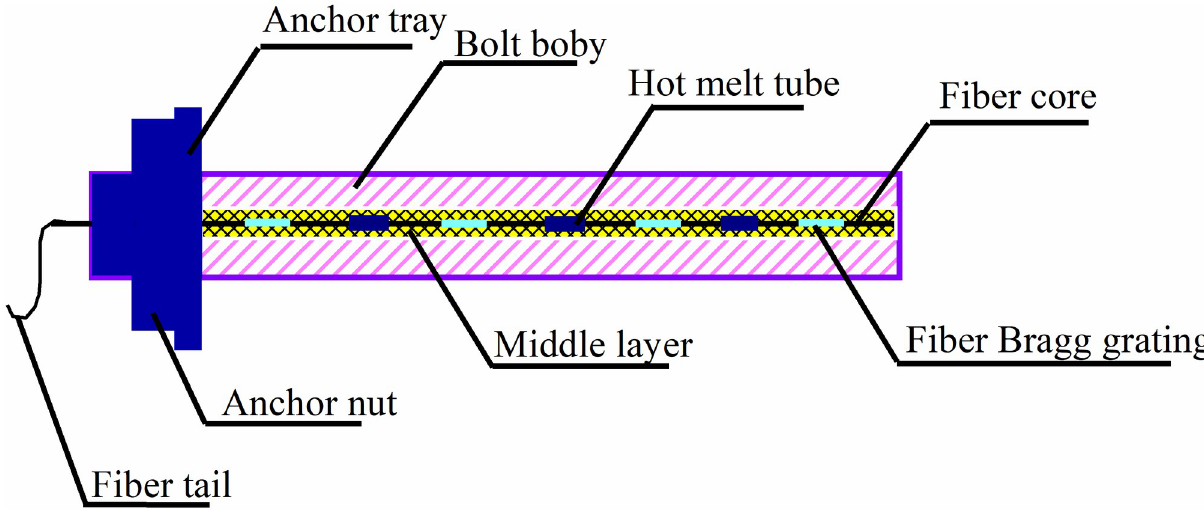
Fig 7. Fiber grating sensor structure layout